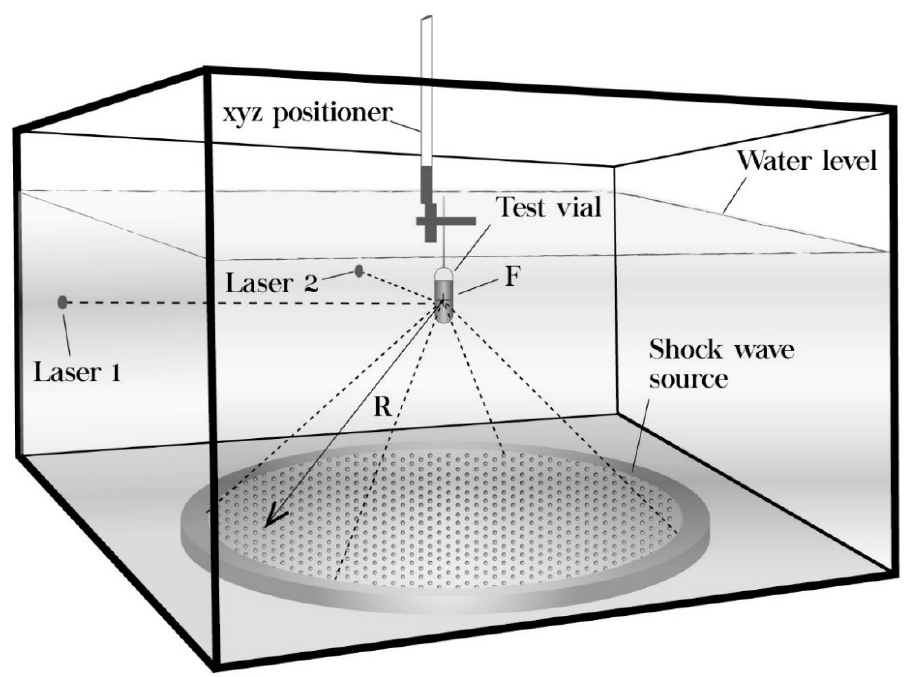
Figure 1. Sketch of the piezoelectric shock wave generator used to expose suspensions of fungal conidia to single-pulse and tandem shock waves. R = 345 mm (Figure adapted from [56]).